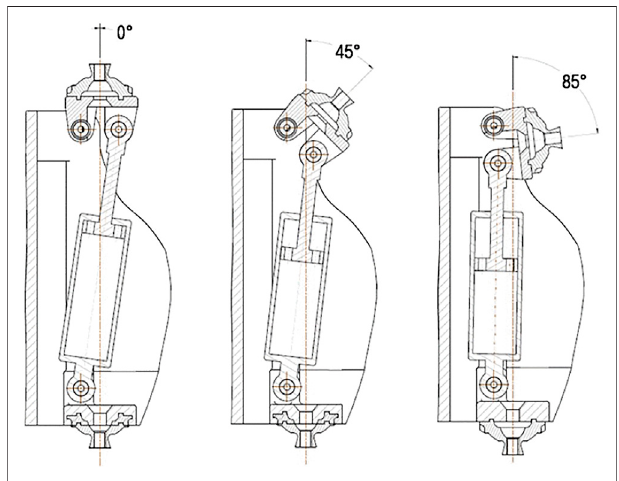
FIGURE 7 | Mechanical design of prosthetic knee joint with magnetorheological actuator (Torrealba et al., 2010).